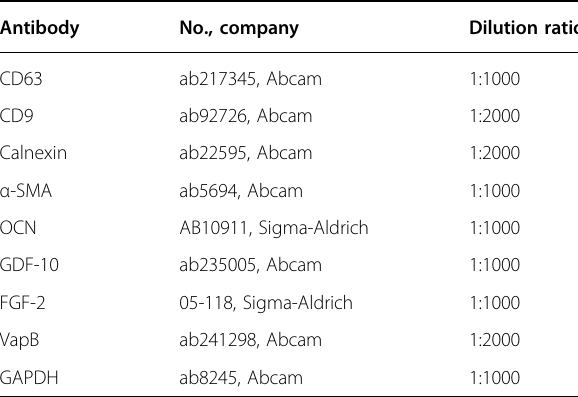
Table 2 Antibodies for western blot